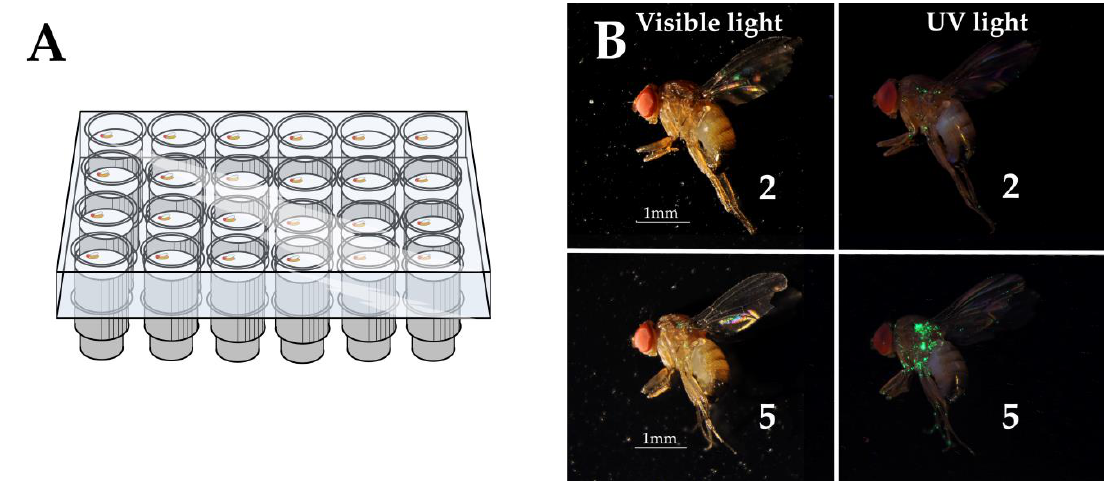
Figure 1. D. suzukii flies were individually kept in observation cells ( A ) to investigate the effect of marking on survival as well as to assess the marking efficiency and persistence for different marking techniques using Radglo ® TP-40: Chartreuse. An illustration of the scoring system (here scores 2 and 5) applied to calculate marking efficiency is given under both visible light and UV light ( B ).